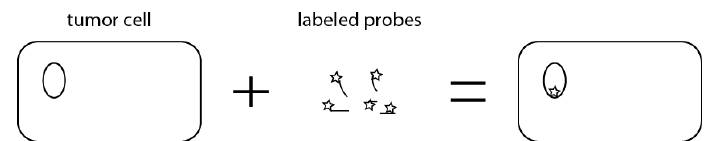
Figure 2. Tumor blocks are unmasked and allowed to hybridize with HPV type specific probes prior to fixation and detection via either fluorescent or bright field